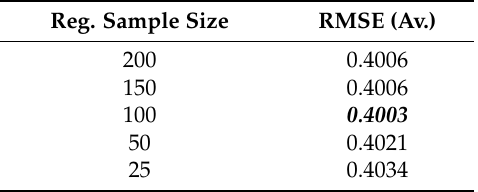
Table A5. Sensitivity of the least median of squares regression (LMSReg) to the sample size.